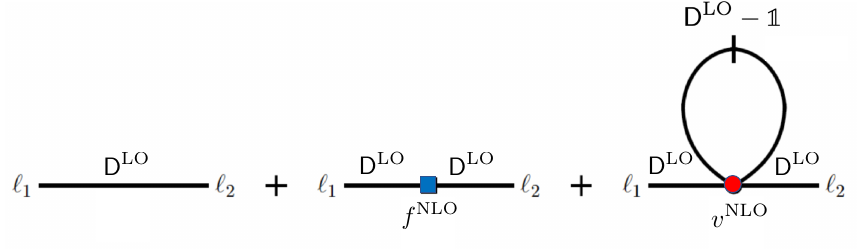
Figure 10 . Graphical representation of the right hand side of (E.15). The first term corresponds to the LO “propagator” D LO defined in (E.14). The second term represents the NLO contribution to the propagator arising from the quadratic “vertex” f NLO defined in (E.12) which we have drawn as a blue square. The last term describes the contribution due to the quartic “vertex” v NLO given in (E.13) which is represented by a red circle. Note that all lines stand for the propagator D LO . The only exception is the closed line above v NLO , which represents the difference D LO − 1